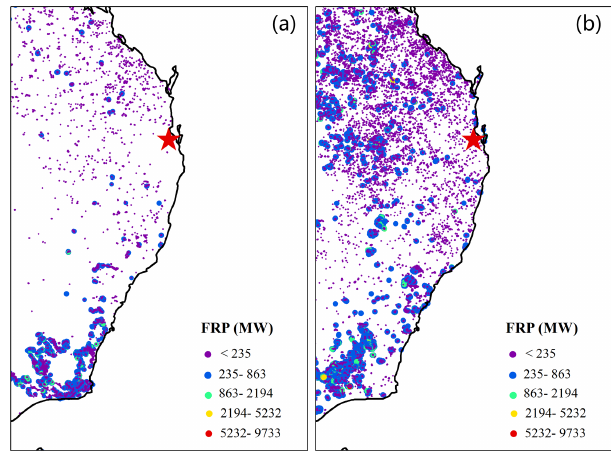
Figure 7. The fire radiative power (FRP) of total fire spots in east- ern Australia during January 2020 (a) and January from 2002 to 2019 (b)